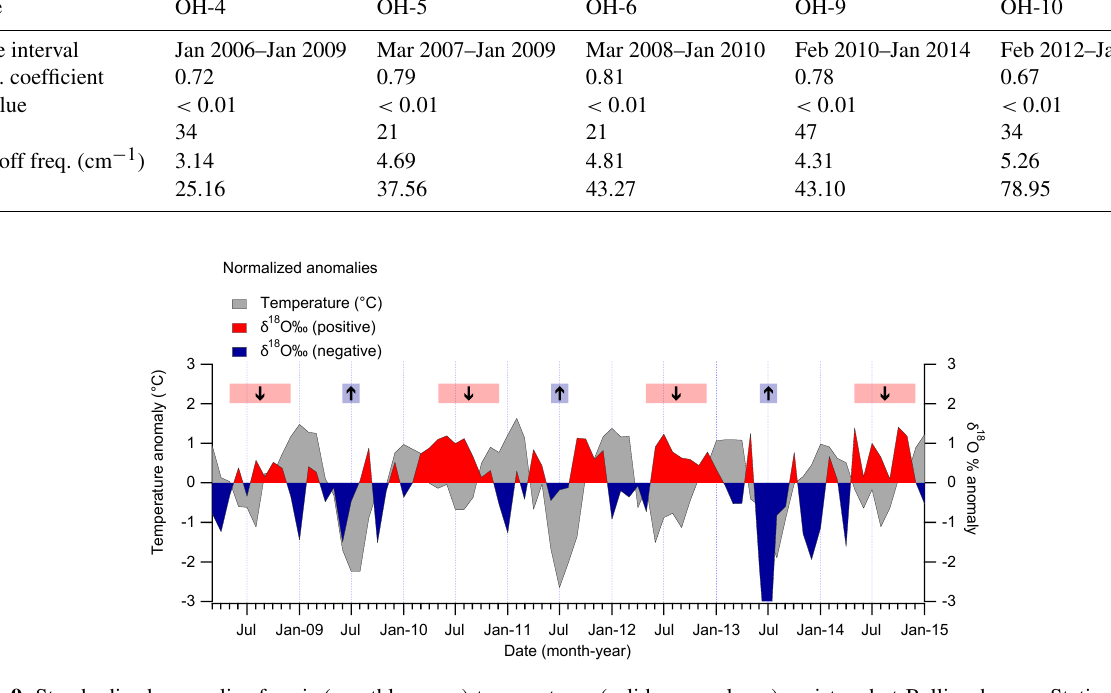
Figure 9. Standardized anomalies for air (monthly mean) temperatures (solid grey colours) registered at Bellingshausen Station (BE) on King George Island and a composite δ 18 O time series derived from firn cores OH-6, OH-9 and OH-10 from Laclavère Plateau. Upper translucent red (blue) boxes show period of positive (negative) anomalies, down (up) arrow shows the negative (positive) stable water isotope–temperature relationship. Both time series were detrended prior to constructing the time series of